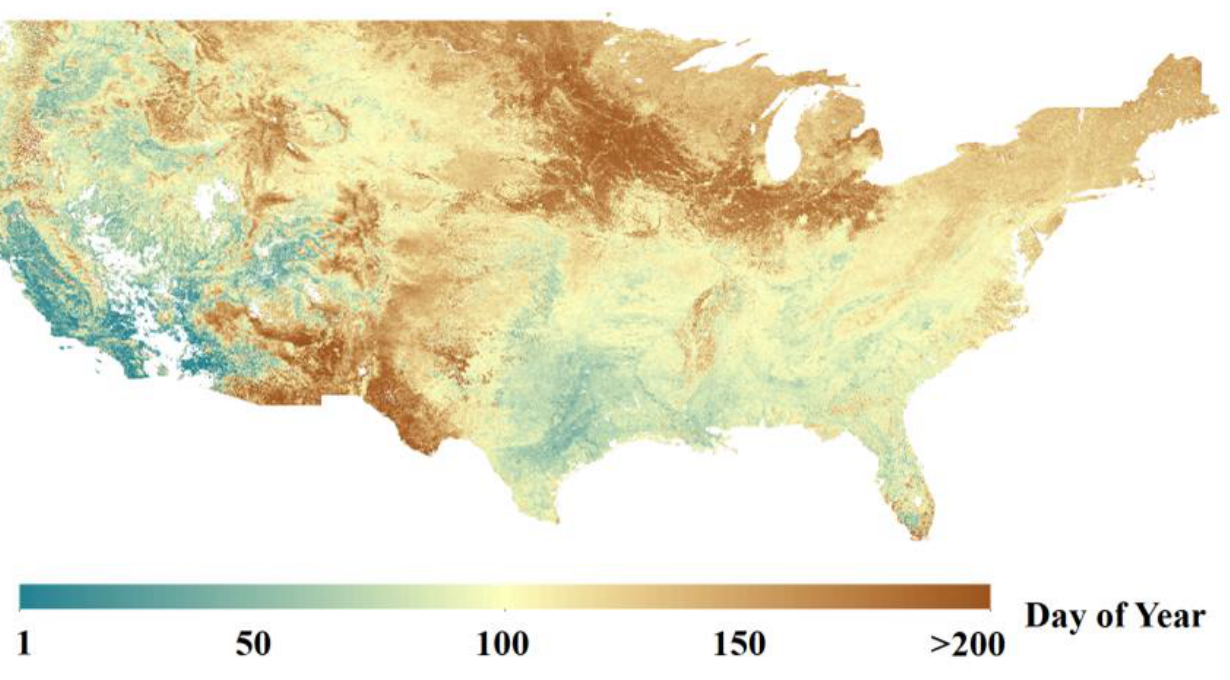
Figure 4. Spatial distribution of 21-year mean SOS in the conterminous United States from 2001 to 2021.